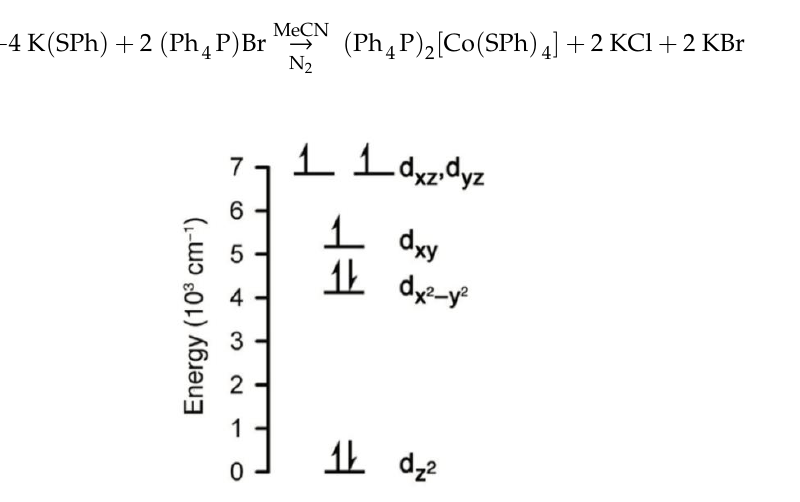
Figure 13. Electronic configuration and splitting of the 3d-orbital energy levels for the complex anion in 17 , derived using the angular overlap model. The diagram was reproduced from reference [104] with the permission of the American Chemical Society.